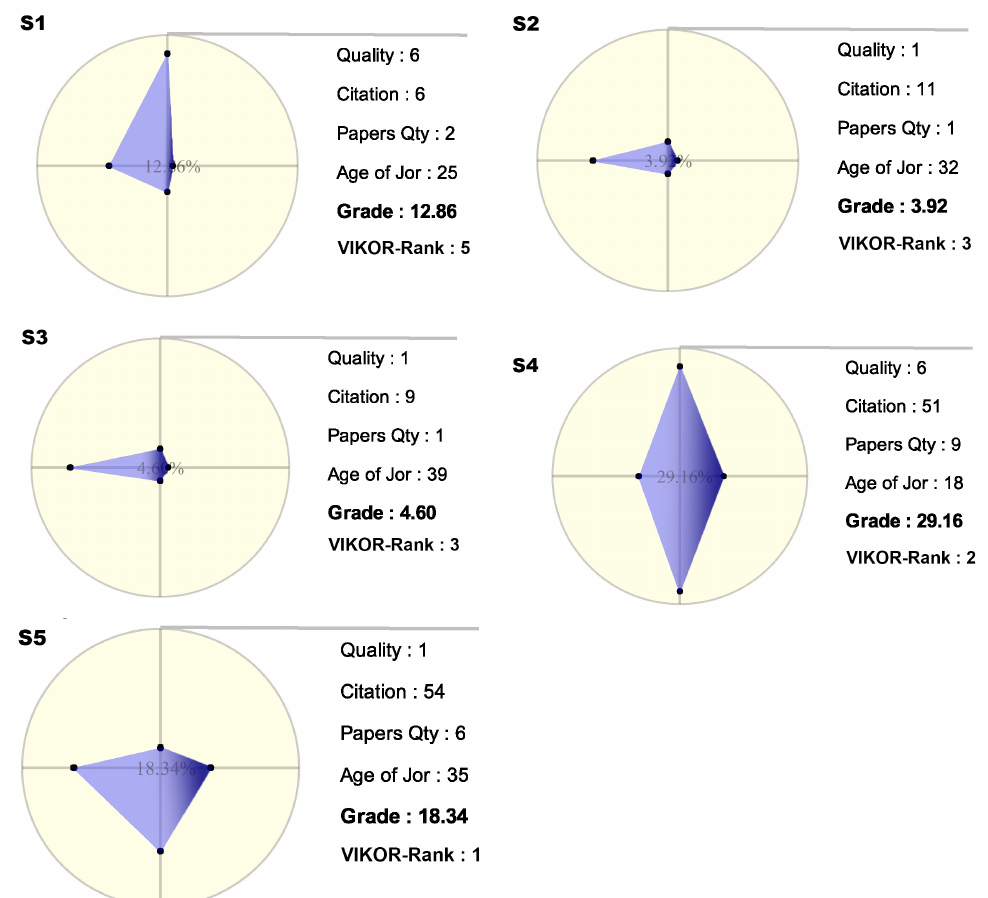
Figure 18. The radar graphs of alternatives which are used as